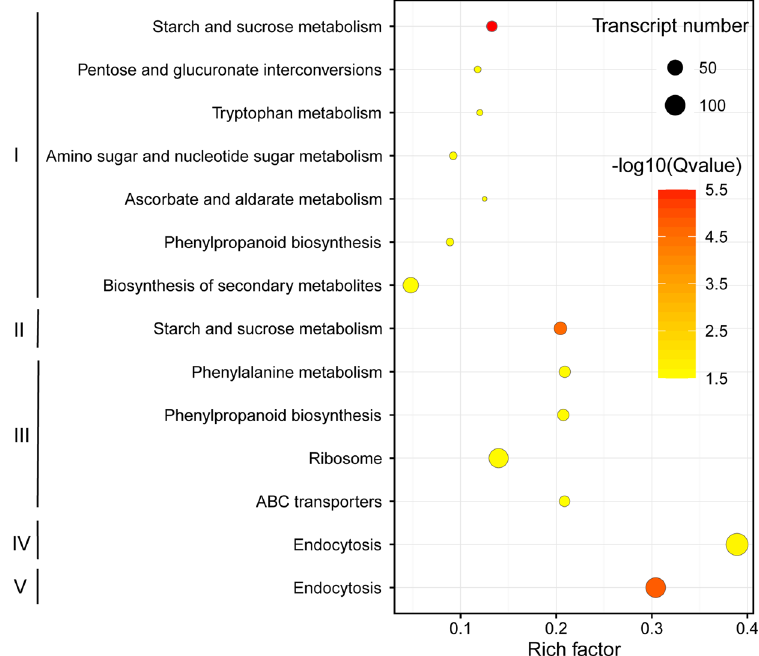
Figure 4. Scatterplot of all statistically enriched KEGG pathways for differentially expressed genes during dehydration and rehydration. The characters I, II, III, IV and V in the figure correspond to the comparisons D2_vs_H0, D24_vs_H0, R2_vs_D24, R48_vs_D24 and R48_vs_H0, respectively. Rich factor was the ratio of the number of SDATs to the total gene number in a specific pathway. The size and color of the dots represent the transcript numbers and the FDR corrected P-values,